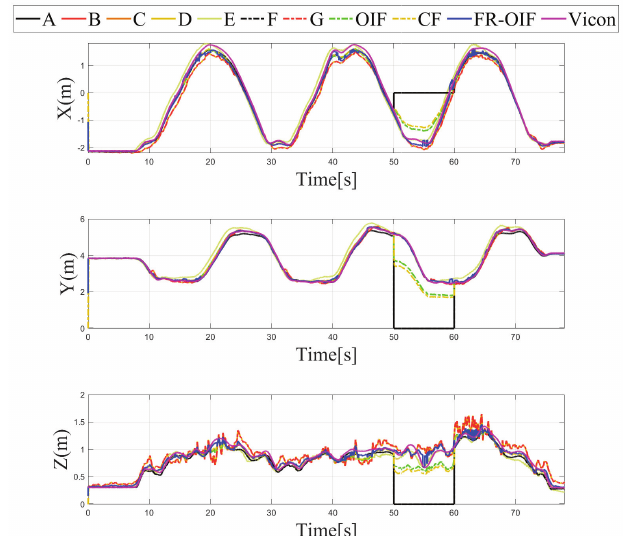
Figure 9. Case-2: Estimated positions along ‘X-Y-Z’ components obtained from intermediate nodes ( A , . . . , G ) and FR-OIF, compared with CF, OIF and the ground truth. The evaluation is carried out in presence of temporal fault appearing from VIO. Except the fused position obtained from FR-OIF all the estimated positions deviated during 50–60